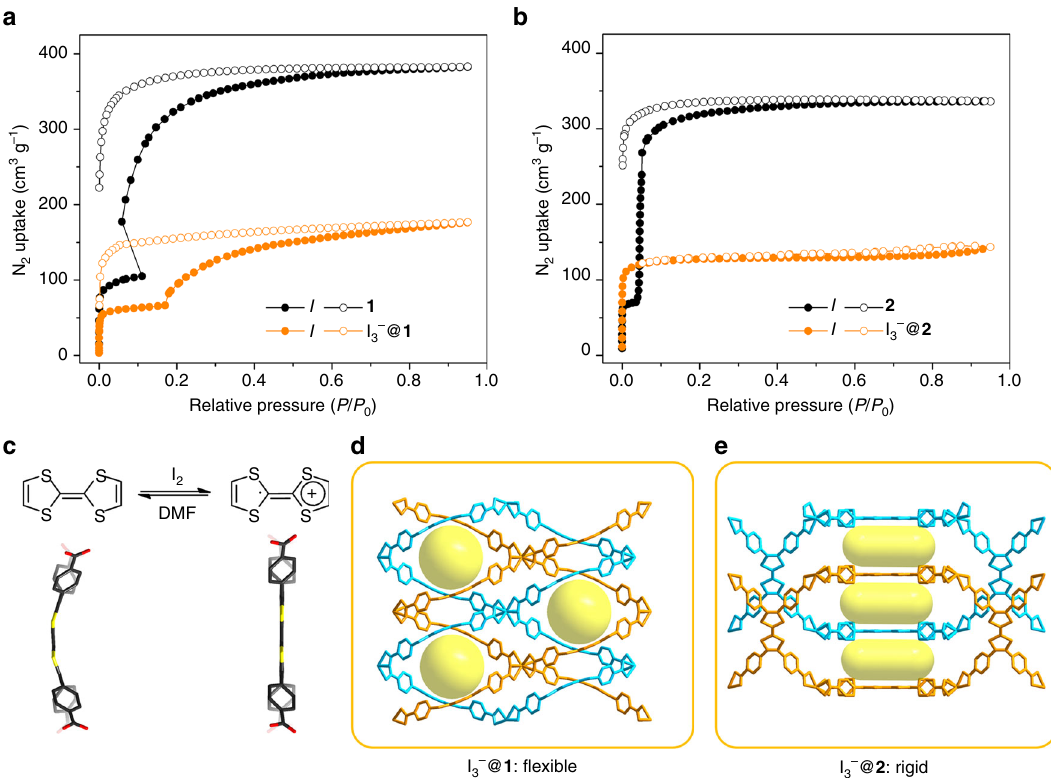
Fig. 4 Redox-switchable breathing behaviors. a , b N 2 sorption isotherms of 1 , I 3 − @ 1 , 2 , and I 3 − @ 2 ; c schematic representation of the electron con fi guration and con fi rmation change upon oxidation/reduction; d , e single-crystal structures of I 3 − @ 1 and I 3 − @ 2 . Two sets of interpenetrated networks were colored blue and orange. The cavities are highlighted by yellow spheres. Color scheme of linkers: O, red; C, gray; S,